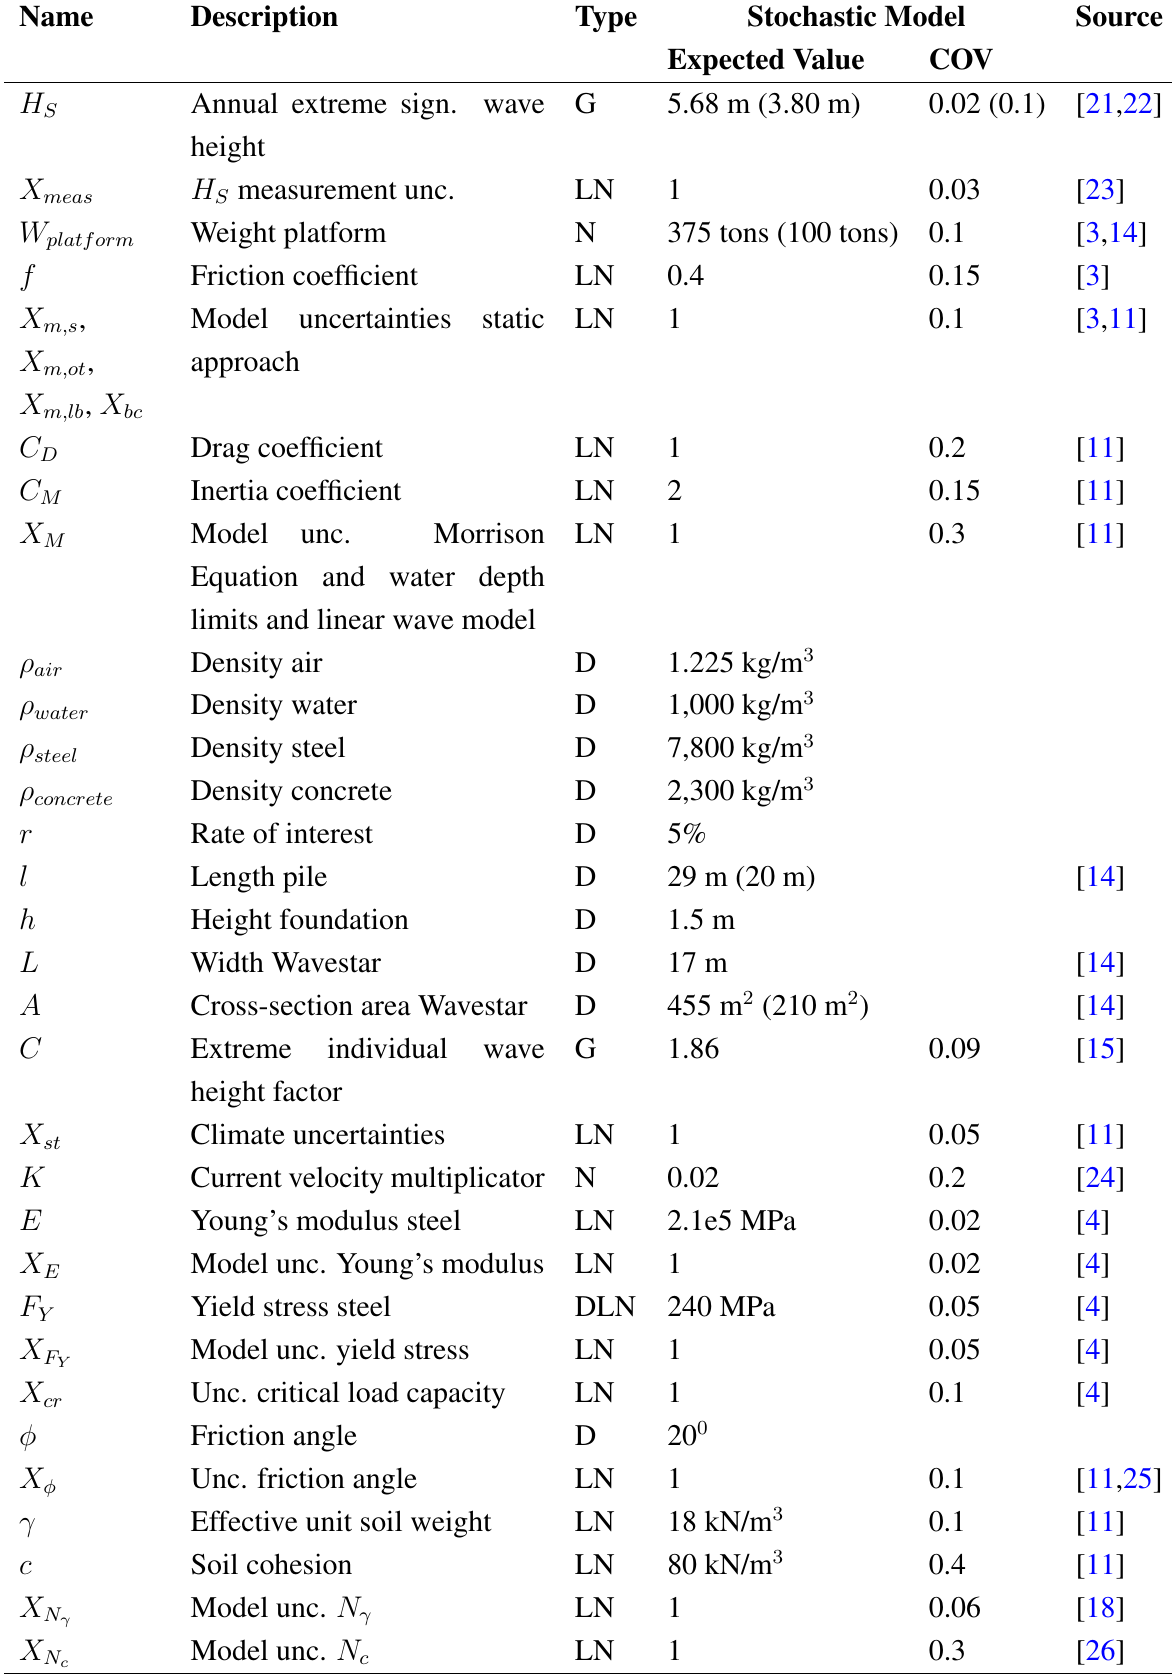
Table 2. Stochastic model used for the different limit states explained in Sections 5.1, 5.2, 5.3 and 5.4. Values in () are only valid for Case 1. G, Gumbel distributed; N, normal distributed, LN, log-normal distributed; D, deterministic; COV, coefficient of variation; unc.,